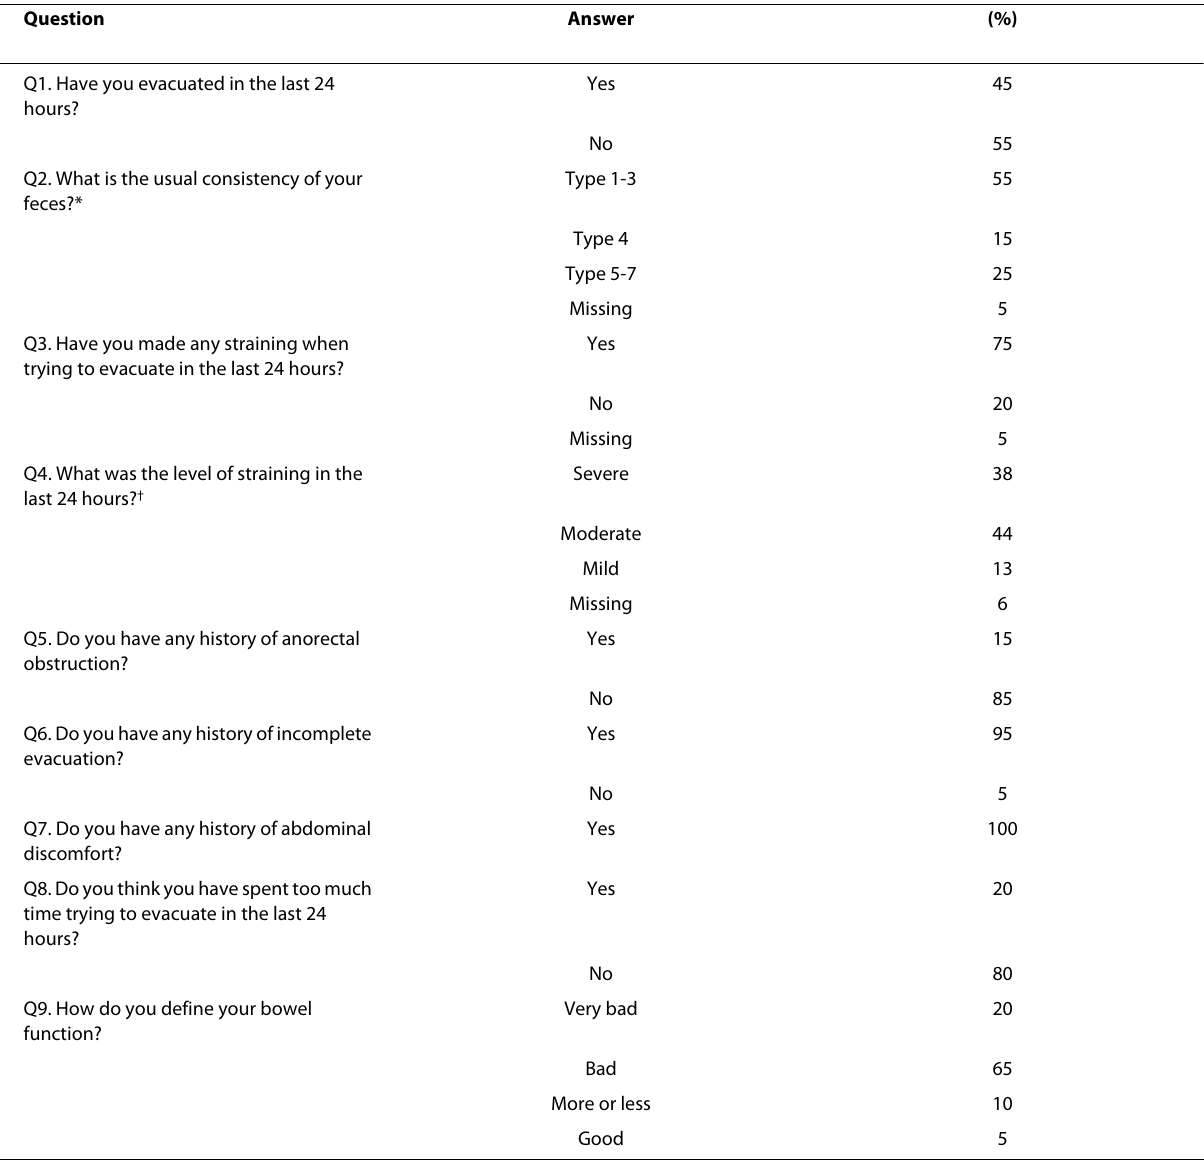
Table 1: Constipation questionnaire and baseline characteristics (n = 20; 19 female)